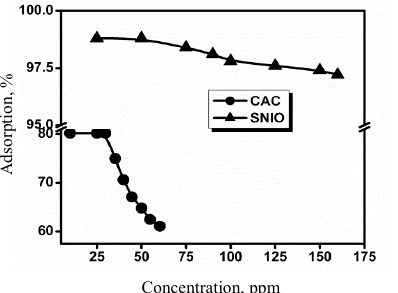
Figure 5. Variation in the percentage removal of the Ni(II) ion by CAC and SNIO with the dose rate of the CAC and SNIO (Ni(II) ion optimum concentration: 29.7 ppm (CAC), 50ppm(SNIO); contact time: 60min; pH